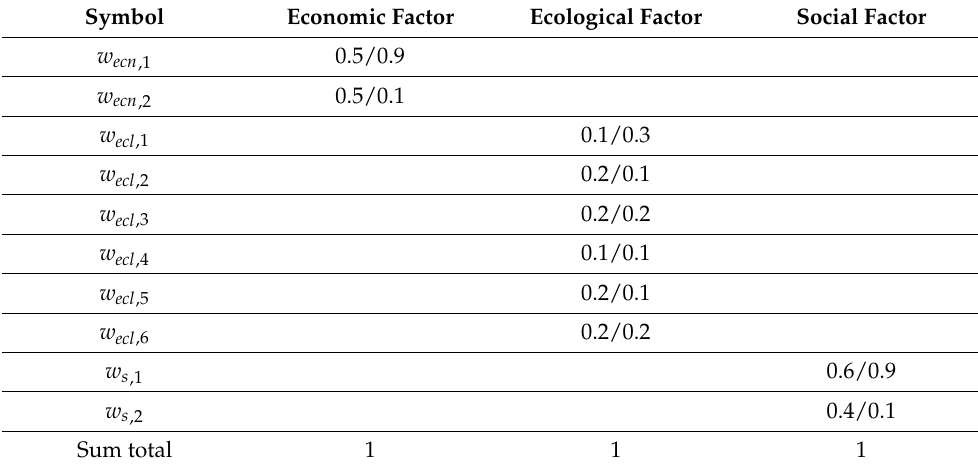
Table 5. Weighting coefficients (mining and